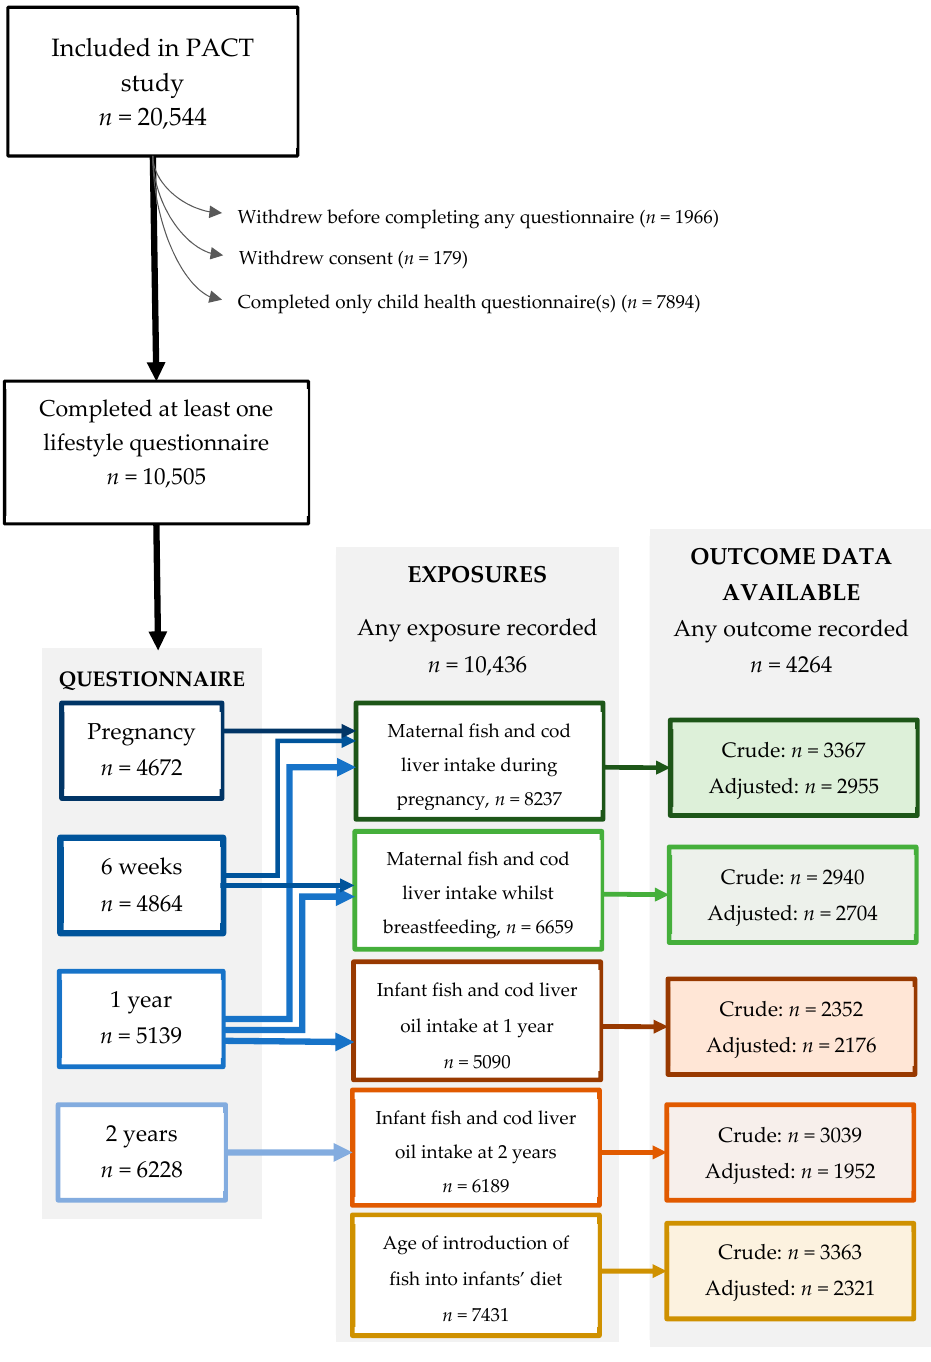
Figure 1. Flow chart for participants. The exact number of participants in each analysis di ff ers slightly due to missing observations for individual exposures and